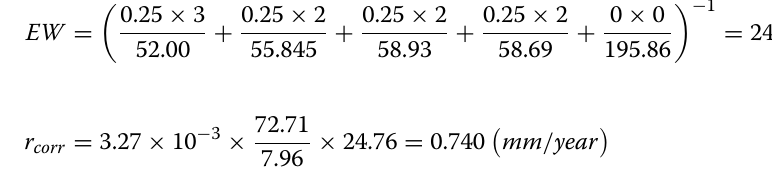
(WC) HEA composites 1-x x I corr. (A/cm 2 )